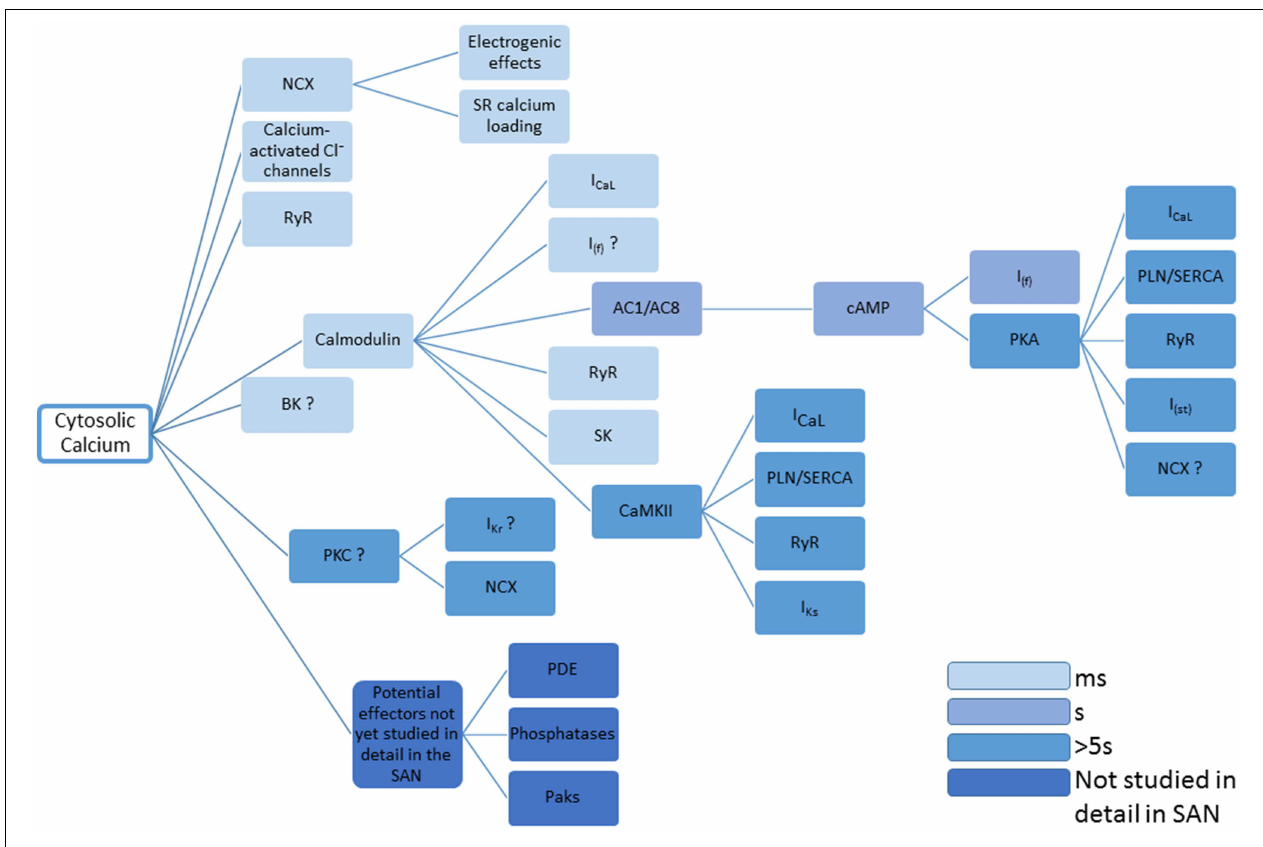
Ca 2 + , though it will be the case that Ca 2 + within the SR will have additional effects, for example through calsequestrin or RyR2 (either via a possible Ca 2 + sensor within the RyR structure, or through inactivation of RyRs that might be influenced by SR Ca 2 + ). Also omitted are the possible roles of NO produced via Ca 2 + -stimulated nNOS and